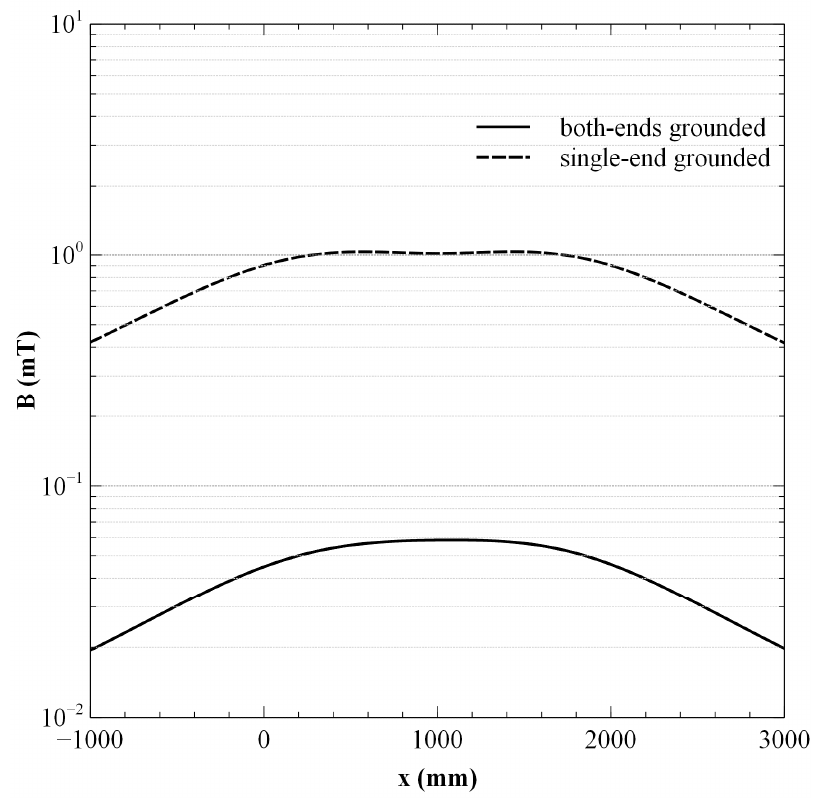
Figure 7. Distribution of total magnetic flux density along the observational profile located 1 m from the symmetry line of the busduct system for both of the screen